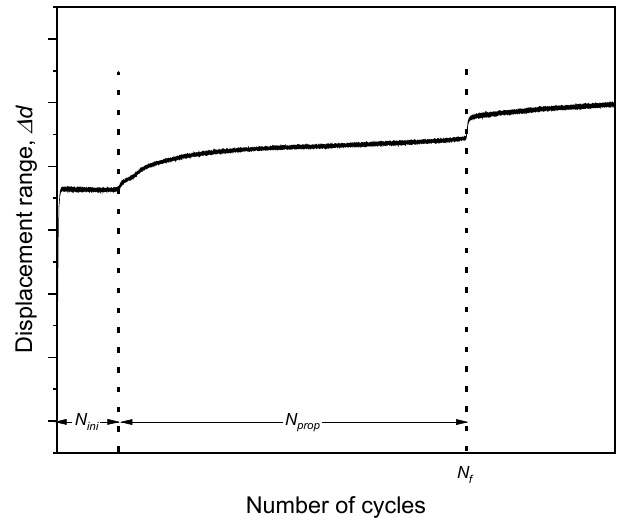
∆ d as a function of the number of cycles.